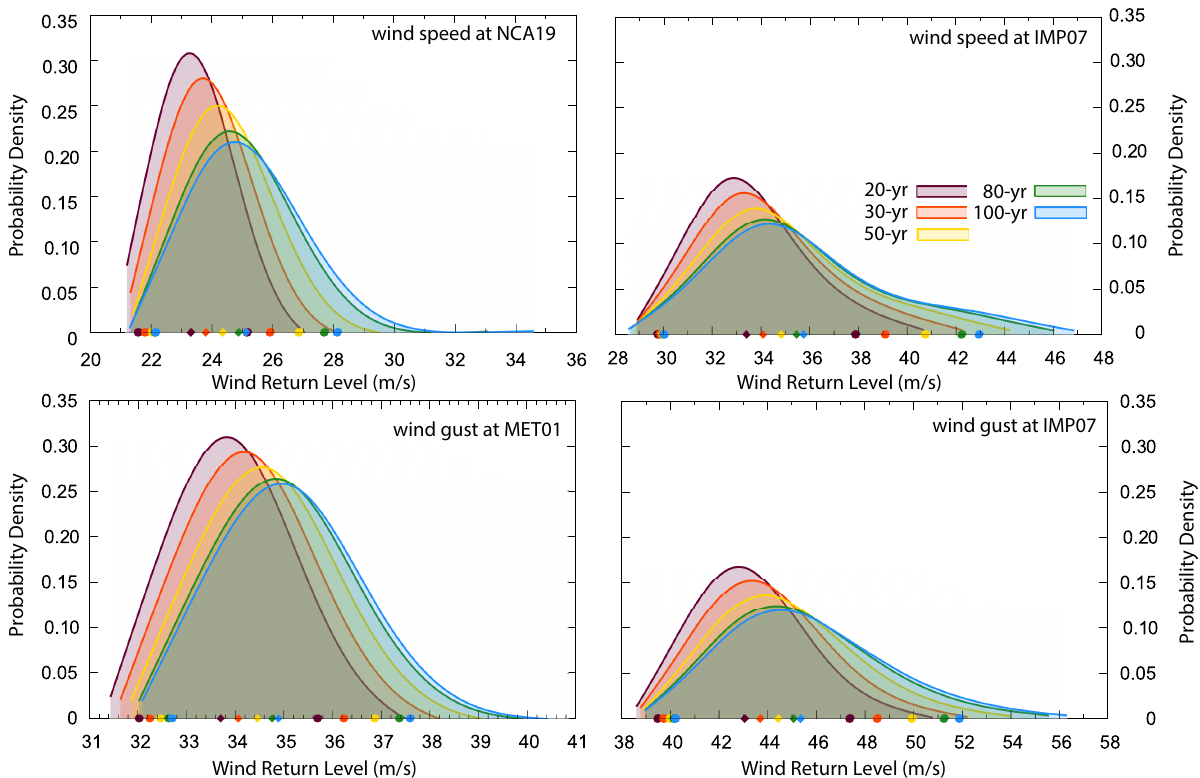
Figure 9. Combined PDFs of the wind return levels for 20-, 30-, 50-, 80- and 100-year return periods (see legend for colors) at some of the sites within the database as an example. Each PDF is built upon the experiments that fulfill the pool of filters applied to the ca. 10,000 initial experiments. Symbols indicate the 5th and 95th percentiles (circles) and the median (diamonds) of each